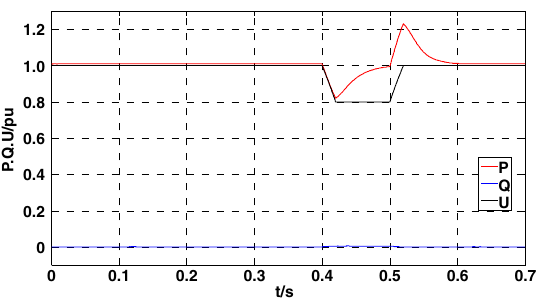
Fig. 4 External characteristics of VRB energy storage system